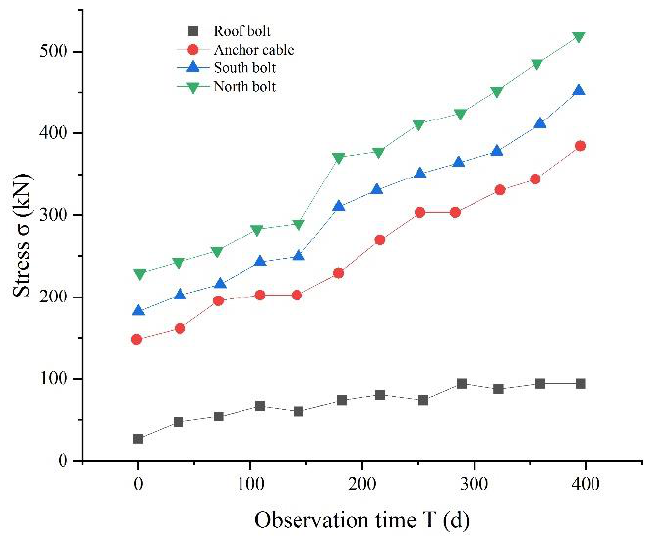
Figure 11. Variation trend of the stress borne by the anchor bolt (cable) in the second group of er- gometers in the conveyor roadway of the 360,805 working face.